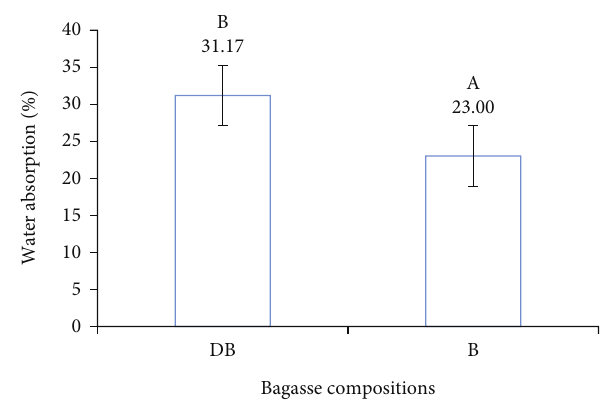
Figure 3: E ff ect of raw material composition on water absorption on depithed bagasse (DB) and bagasse (B) (values followed by the same letter indicate nonsigni fi cant di ff